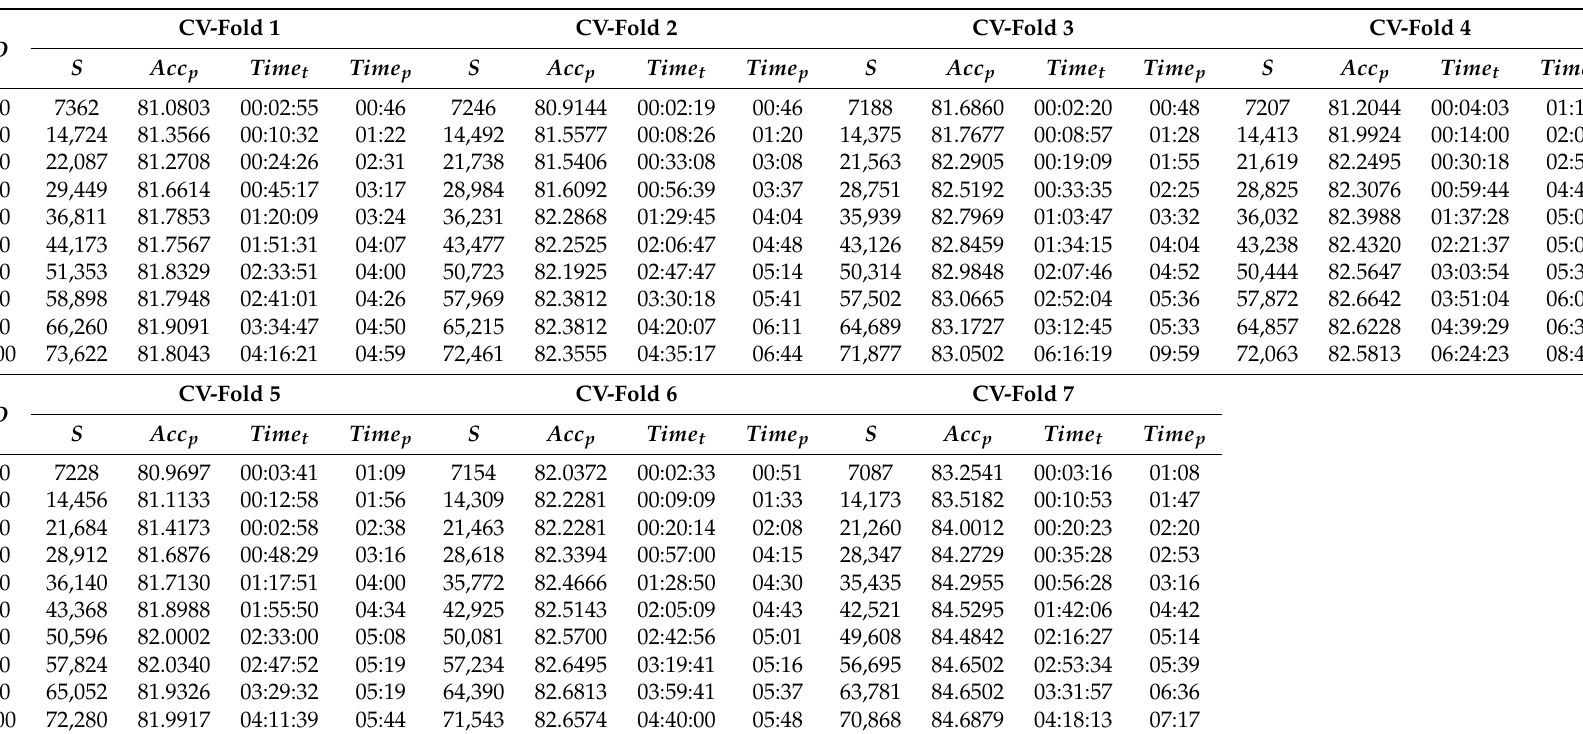
Table 1. Overall prediction accuracies of the stratified random selection method using the various training samples and k -fold ( k = 7)